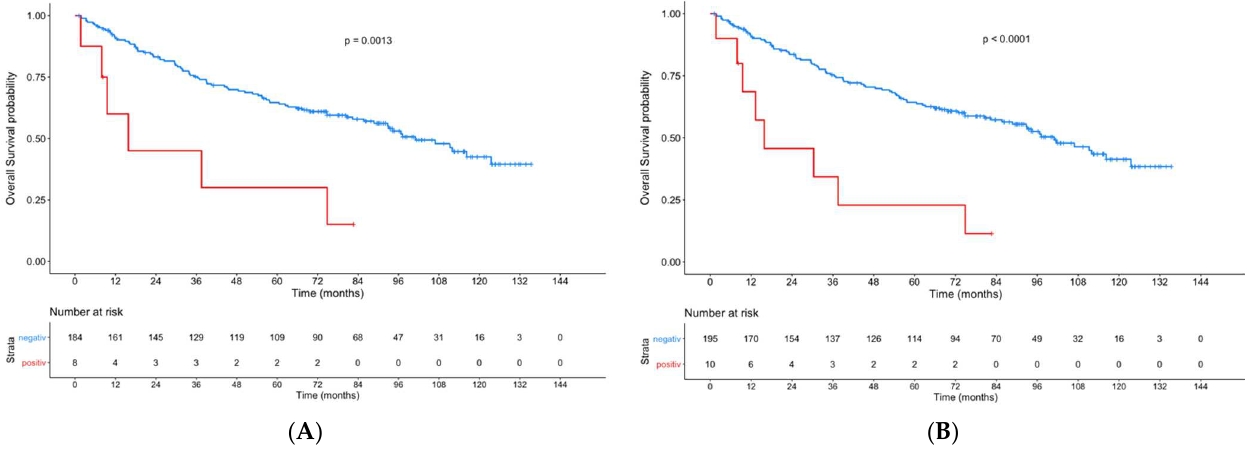
Figure 4. Kaplan–Meier curves showing the OS of male patients with an ERα-positive primary tumor ( A ) and the OS of male patients with ERα-positive lymph node metastasis and/or primary tumor ( B ) compared to patients with ERα-negative tumors.